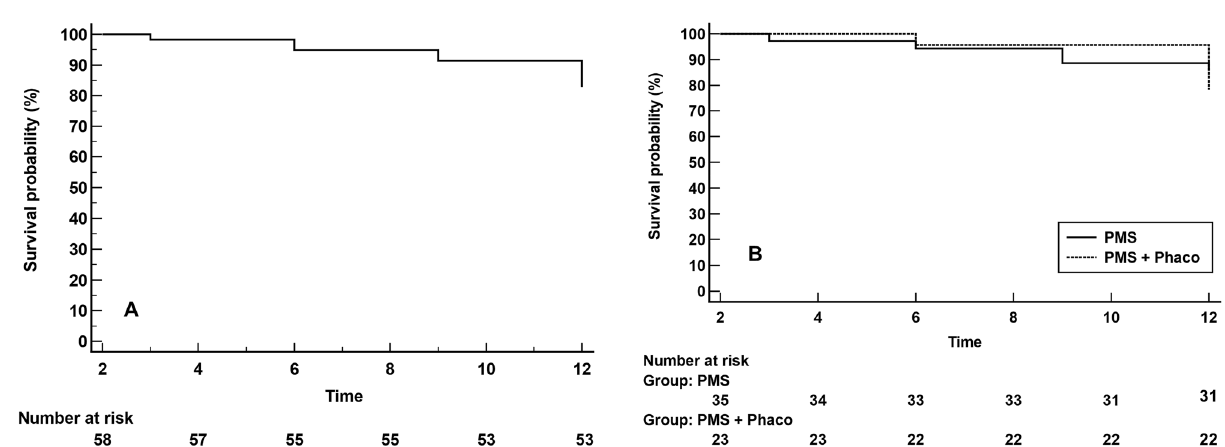
Figure 3. Kaplan–Meier survival curves for failure. ( A ) In the overall study sample. Failure occurred in 10 (17.2%) eyes. ( B ) In eyes treated with PMS alone (solid line) and combined surgery (PMS + Phaco) (dotted line). Failure occurred in 5 (14.3%) PMS-treated eyes and 5 (21.7%) PMS + Phaco-treated eyes. Mean hazard ratio (HR) 0.67, 95% confidence interval 0.18 to 2.44); p = 0.5440.